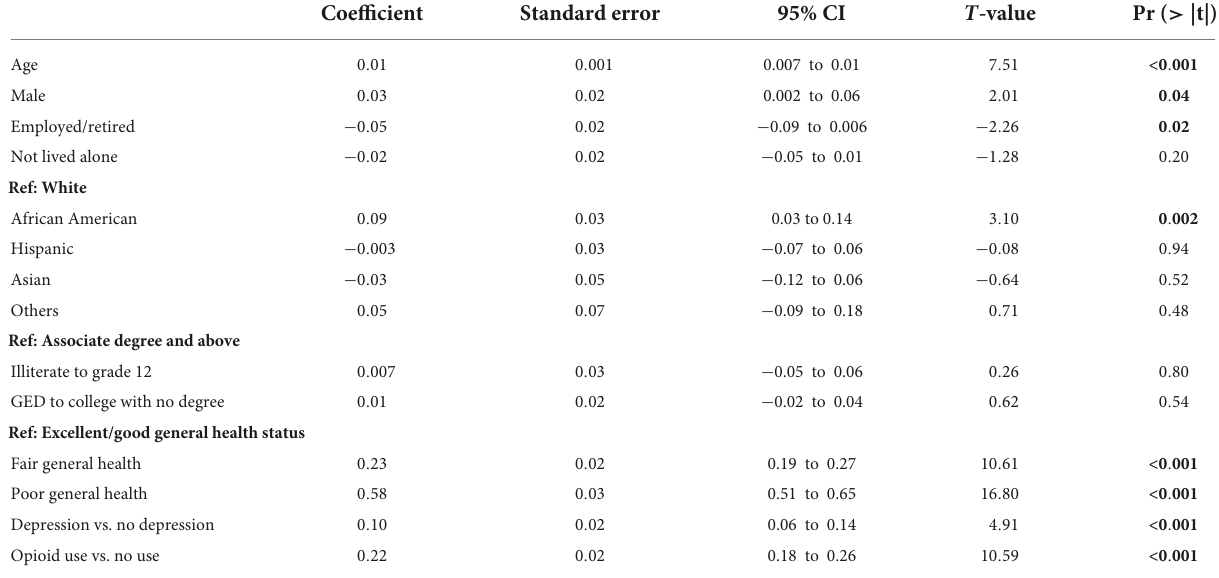
TABLE 2 Linear regression on the relationship between prescribed opioid use and emergency department visits.